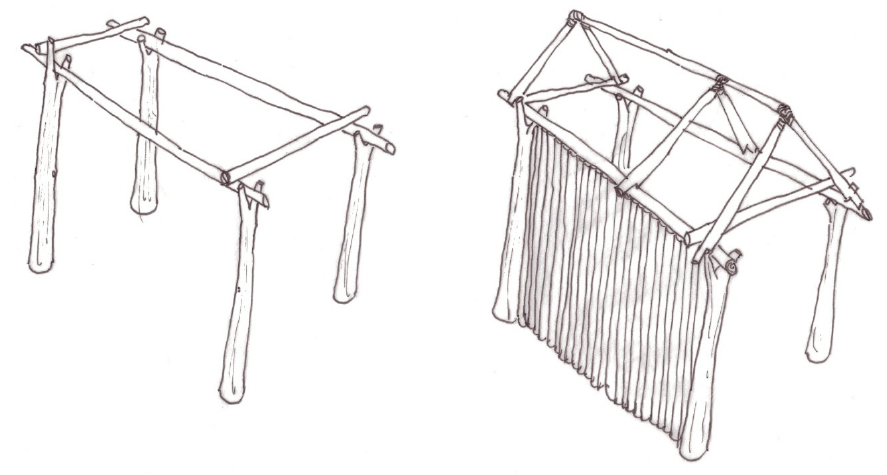
Figure 5. Study on the assembly of the Cordoba Vernacular cabin. Source: Massimo Leserri, 2017 [4].